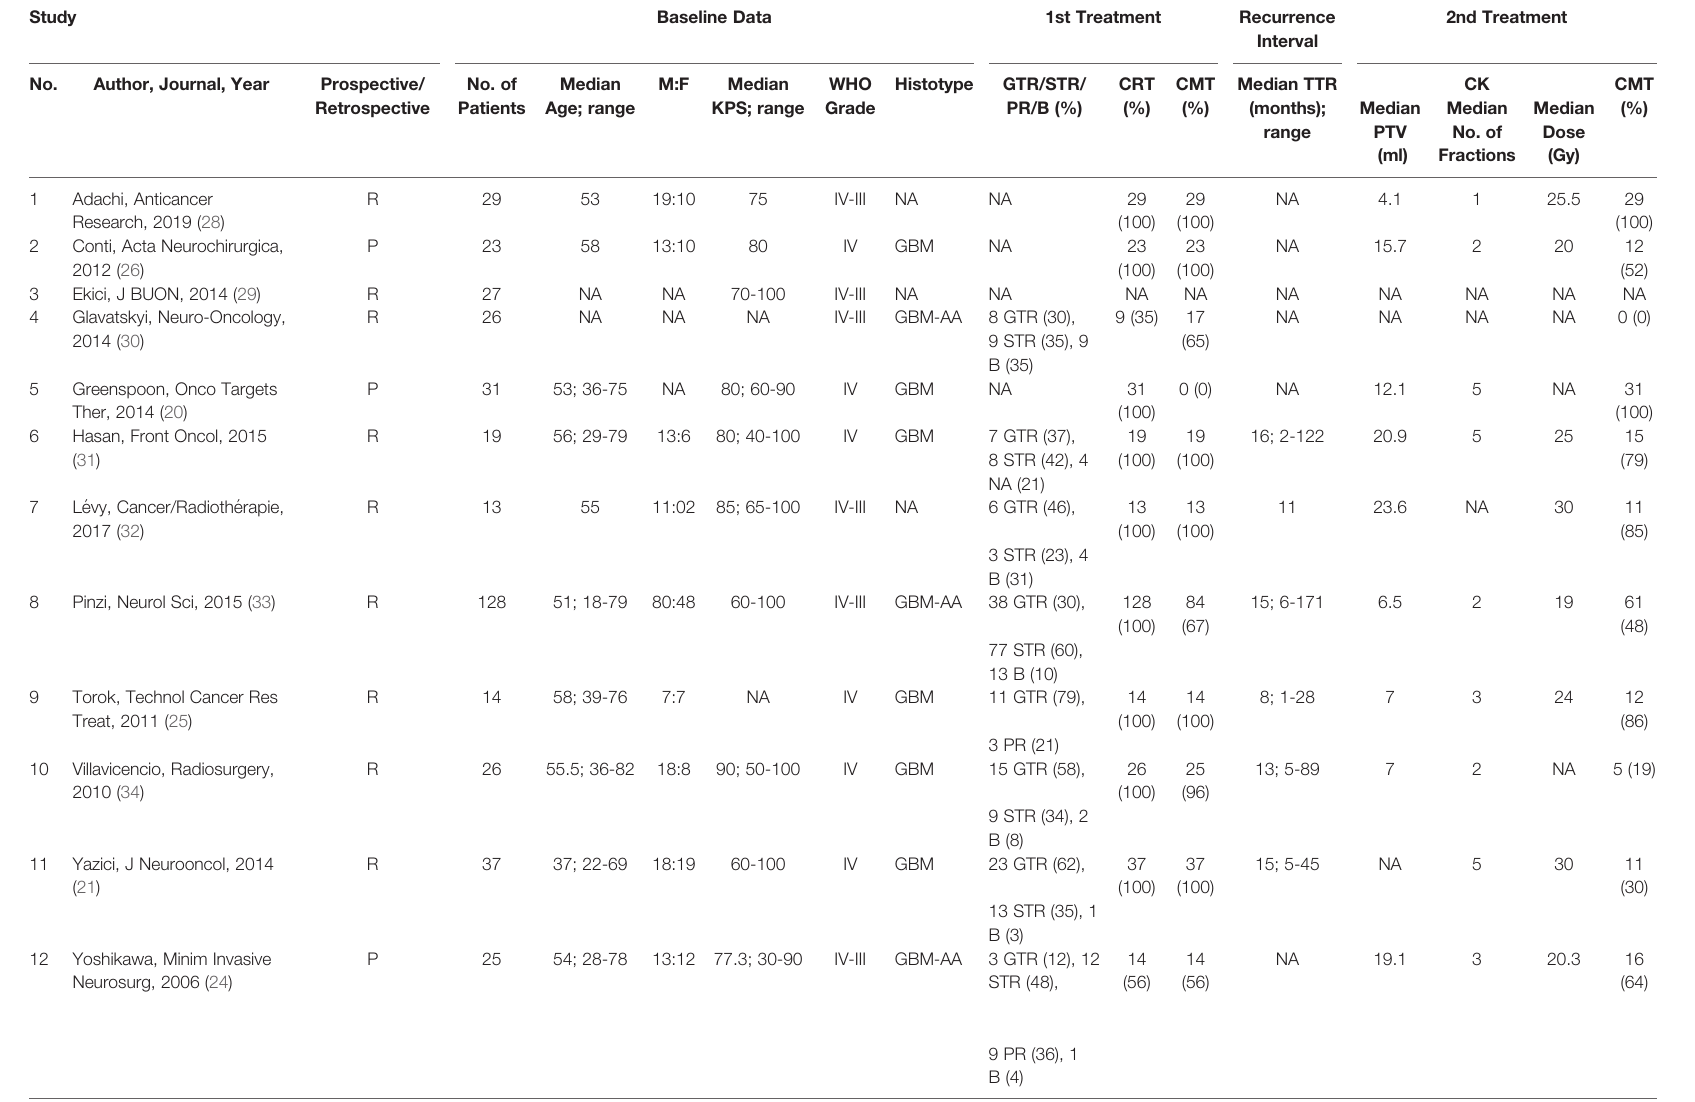
TABLE 1 | Summary of